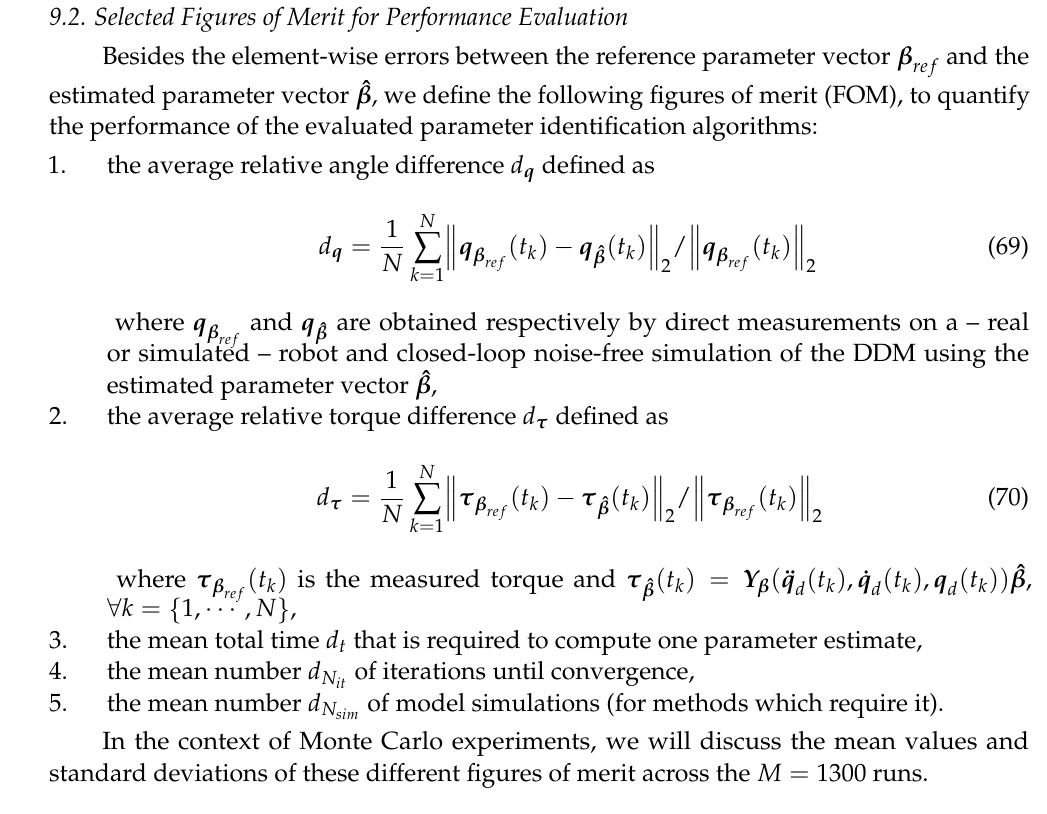
Figure 8. The left and center figures denote the end-effector trajectories—desired in green and actual in dark blue—executed during the experiments on the real robots and visualized on Rviz using the Matlab-ROS interface. The excitation trajectory of the TX40 was manually generated, with trapezoidal velocity profiles and was later imported into BIRDy, while that of the RV2SQ was directly generated using the benchmark Fourier trajectory generation tool. The rightmost figure depicts the experiment setup used for drive gains identification on the Mitsubishi RV2SQ. Note the external payload, with known inertial parameters, attached to the end-effector of the